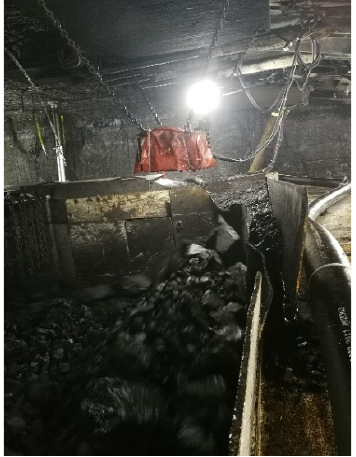
Figure 13. On ‐ site work diagram of scraper conveyor. Figure 13. On-site work diagram of scraper